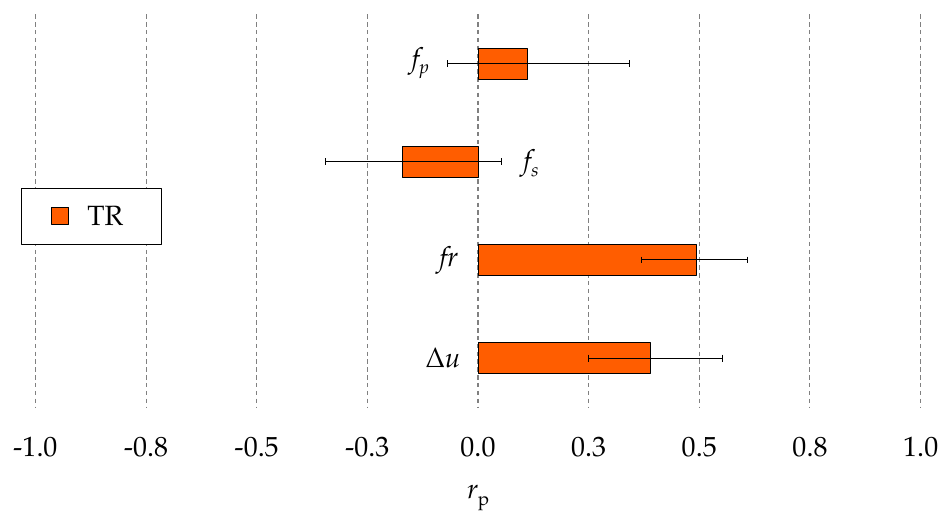
Figure 12. Pearson’s correlation coefficients ( r p ) of the potential indicators for the process fingerprint to the taper ratio (TR). Mean values and ranges of the four experimental repetitions are shown.